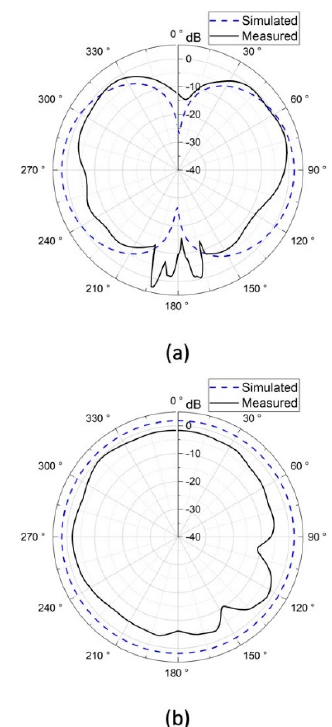
Figure 14. The gain patterns of the multi-connector stent antenna in ( a ) the E-plane, and ( b ) the H-plane.